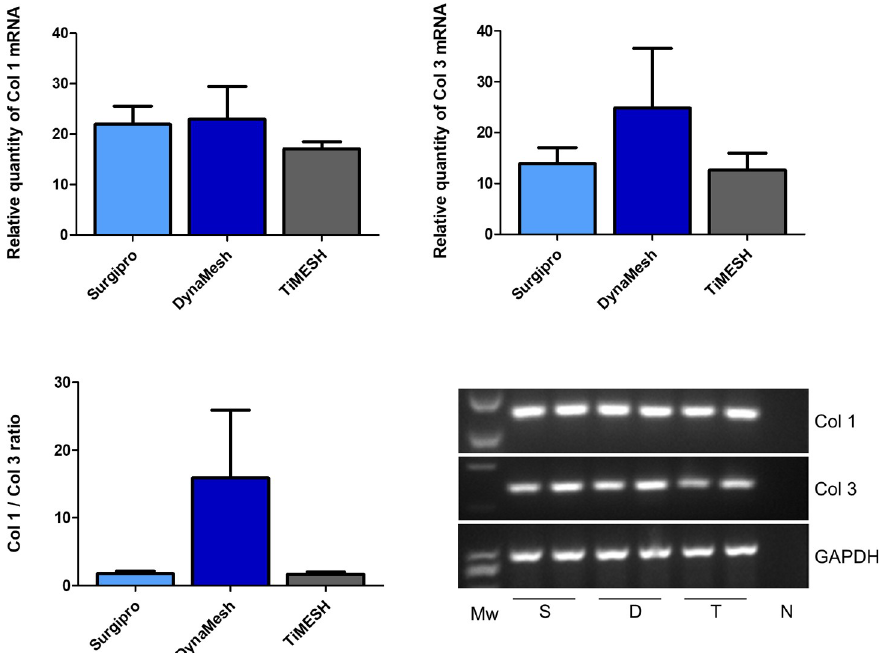
Fig 11. Collagen 1 and 3 mRNA expression levels determined by RT-PCR in adhesion tissue. Relative mRNA levels of collagen 1, collagen 3 and Col1/Col 3 ratios in adhesion tissues from the different experimental groups that developed adhesions (Surgipro, DynaMesh and TiMESH). Gene expression was normalized to the expression recorded for the reference gene GAPDH. Agarose gel electrophoresis of RT-PCR products is shown: S, Surgipro; D, DynaMesh; T, TiMESH. Mw: Molecular weight markers. N: Negative. No significant differences were found for collagen 1 or collagen 3 mRNA expression or for the Col 1/Col 3 ratios.